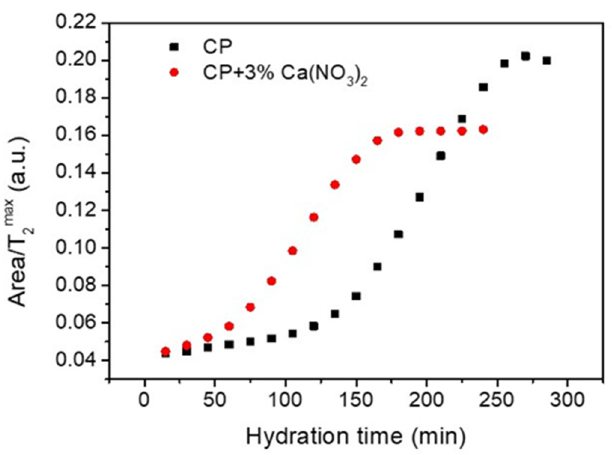
Figure 4. Ratio between the peak area and the peak maximum in the relaxation time distributions shown in Figure 2 for the capillary water component of the two samples, as indicated in the legend. In the case of sample containing the accelerator, the evaluation was restricted to shorter relaxation times due to the overlapping of the capillary peak with the signal corresponding to the C-S-H pores. fractal dimension D f . This quantity can be evaluated based on the log-log representation suggested by Equation (2). The log ( V c ) versus log ( T 2 ) curves are shown in Figure 5